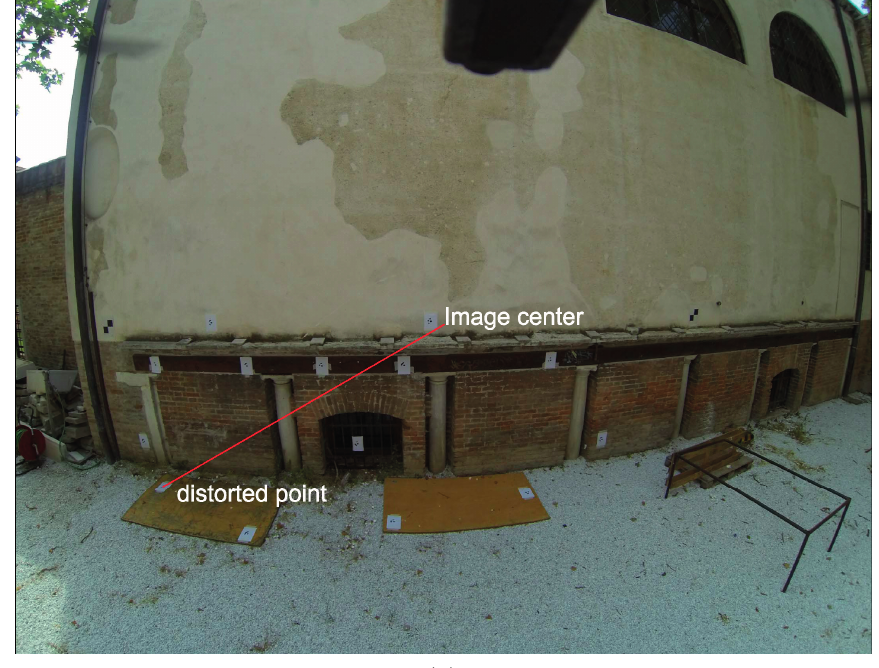
Figure 2. On the ( a ) original and ( b ) idealized images the deformation error is